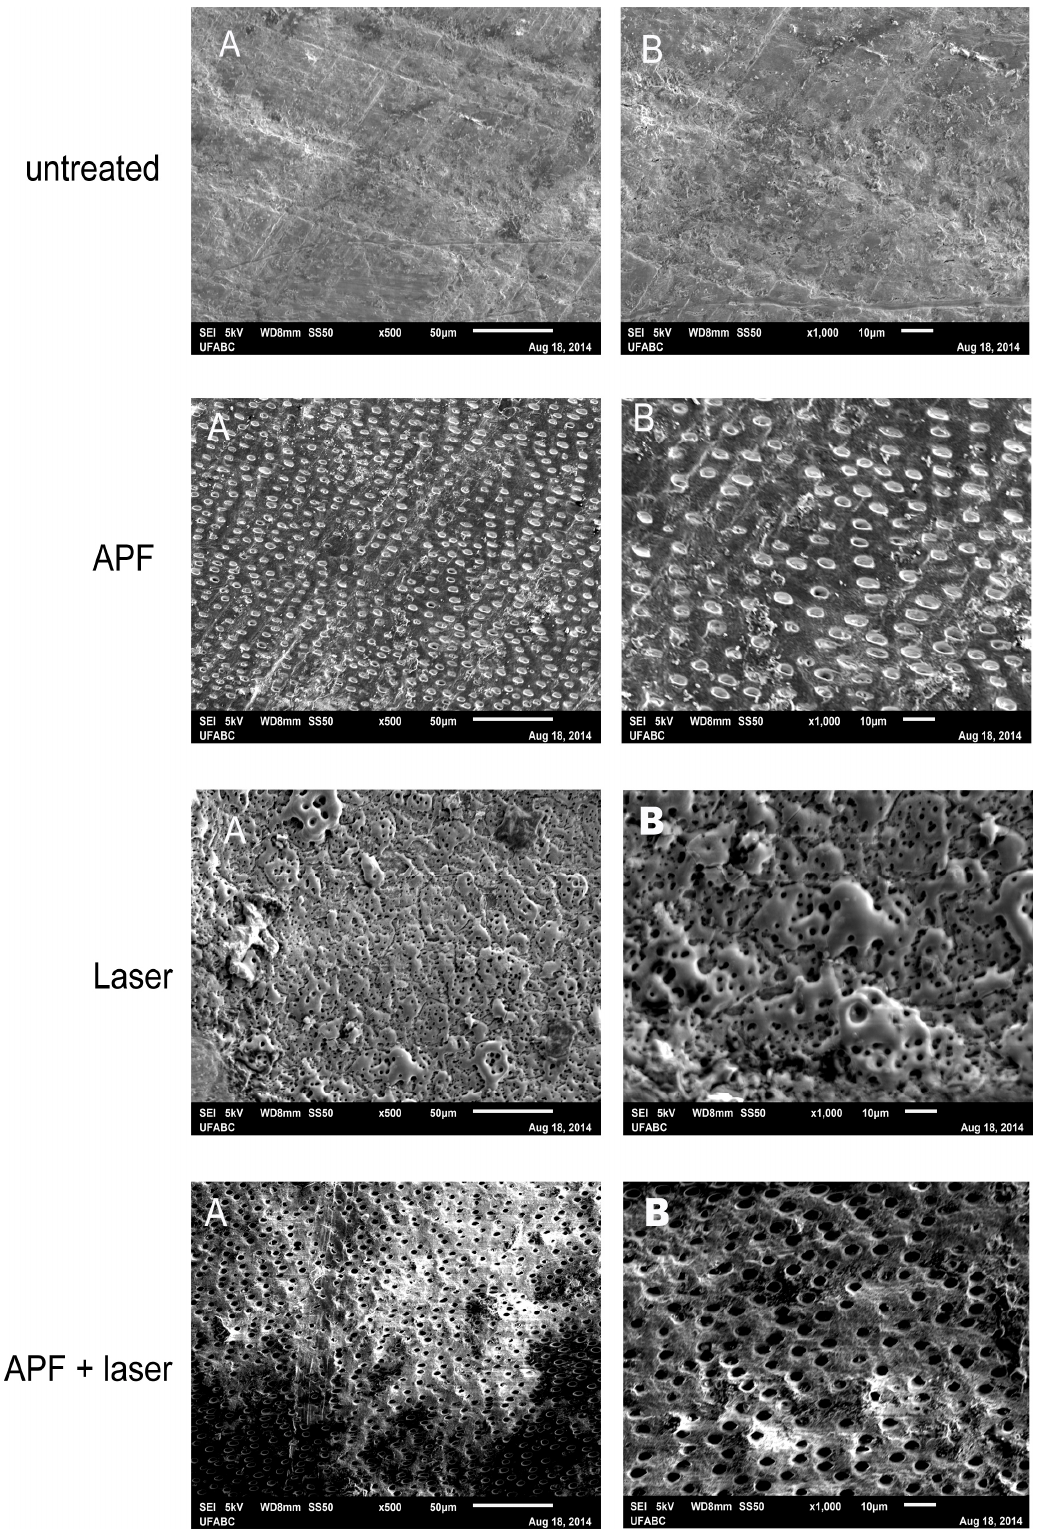
Figure 5. Representative scanning electron microscopy (SEM) images of dentin surfaces of each experimental group, immediately after treatments. Original magnification: ( A ) 500×; ( B ) 1000×.